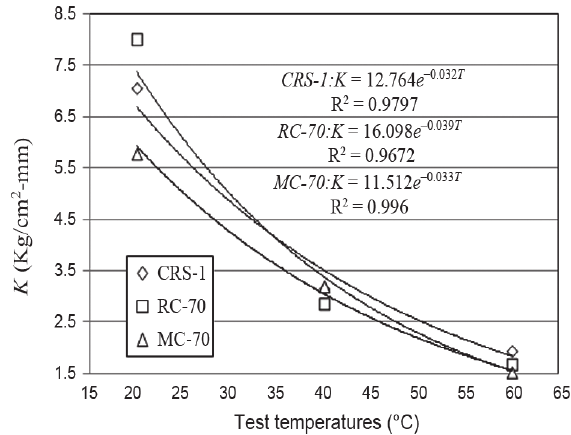
Fig. 6. Interface reaction modulus and temperature relationships